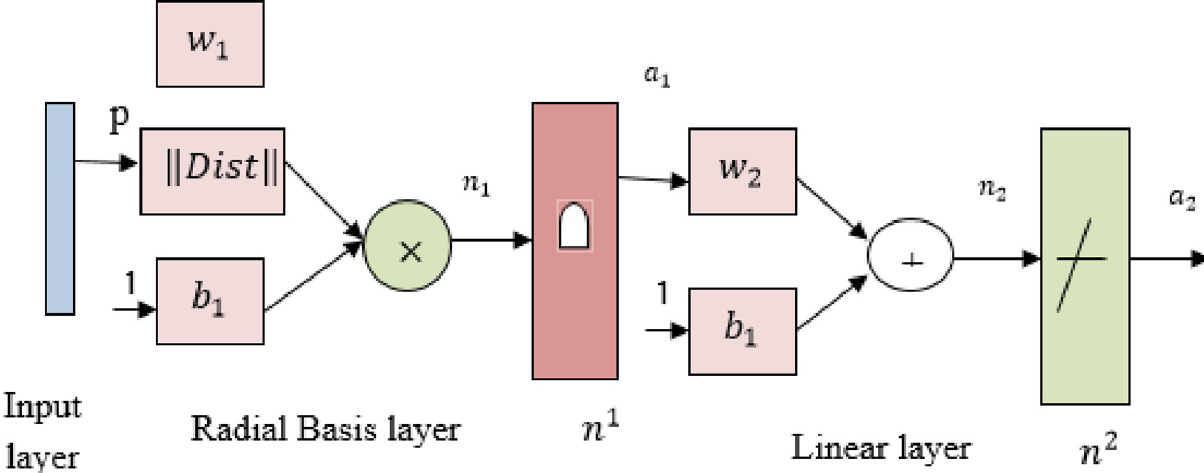
Fig 4. Structure of Radial Basis Function Neural